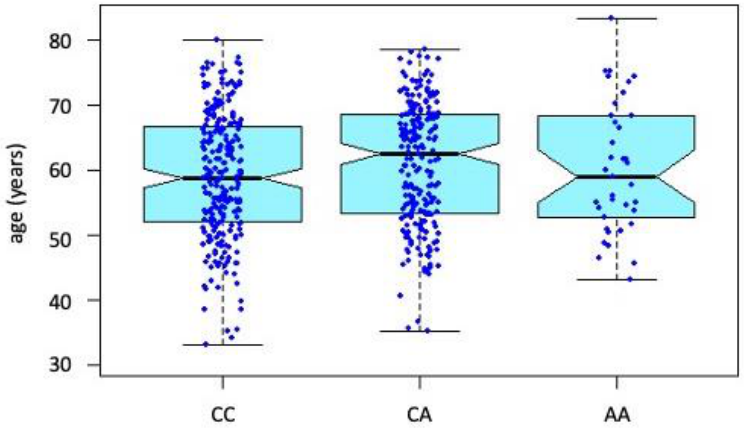
Figure 3. Distribution of age at the time of elective coronary angiography between individual gen- otypes .